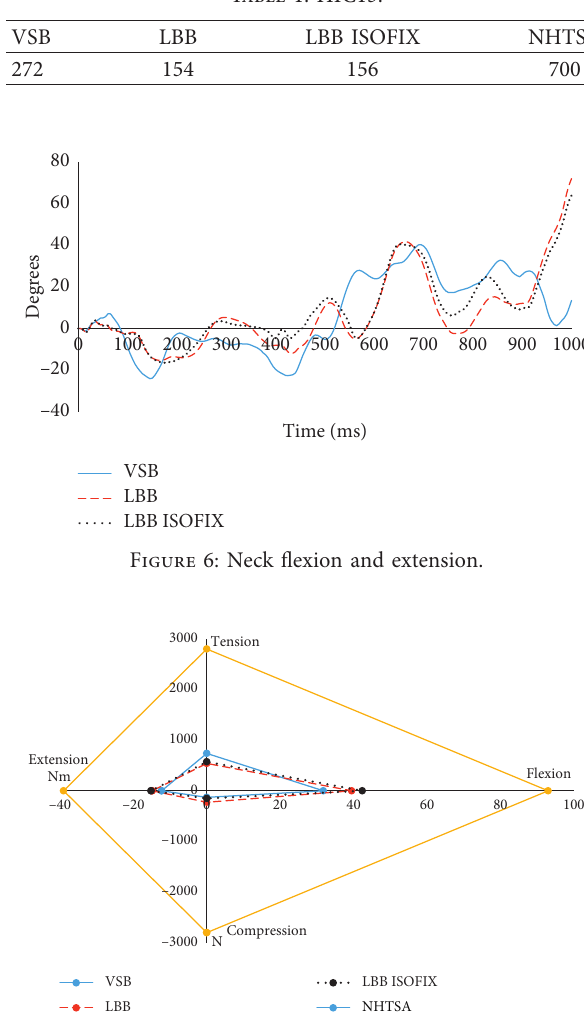
Figure 7: Neck injury